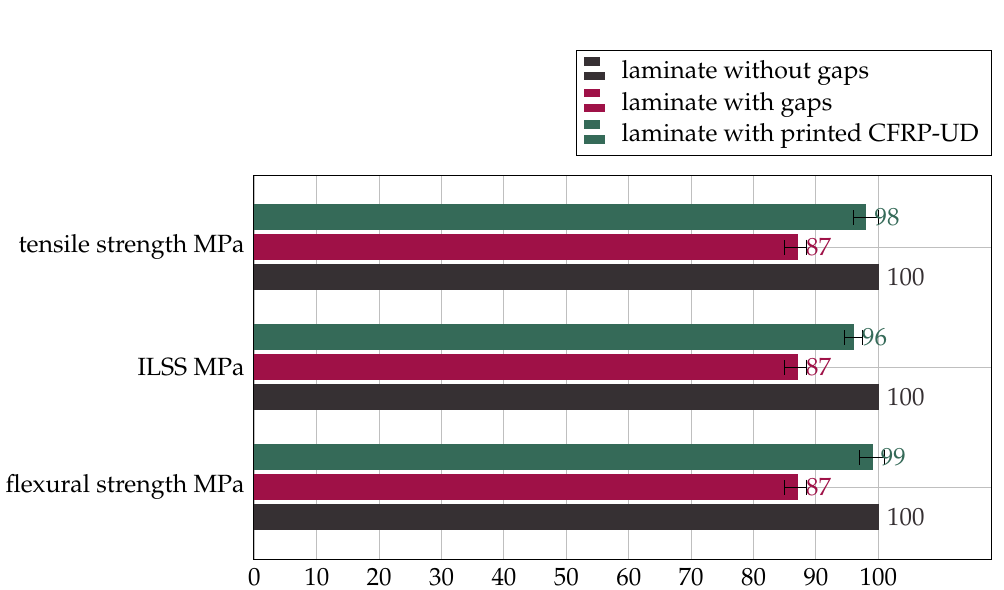
Figure 8. Comparison of the mechanical properties of the laminates.